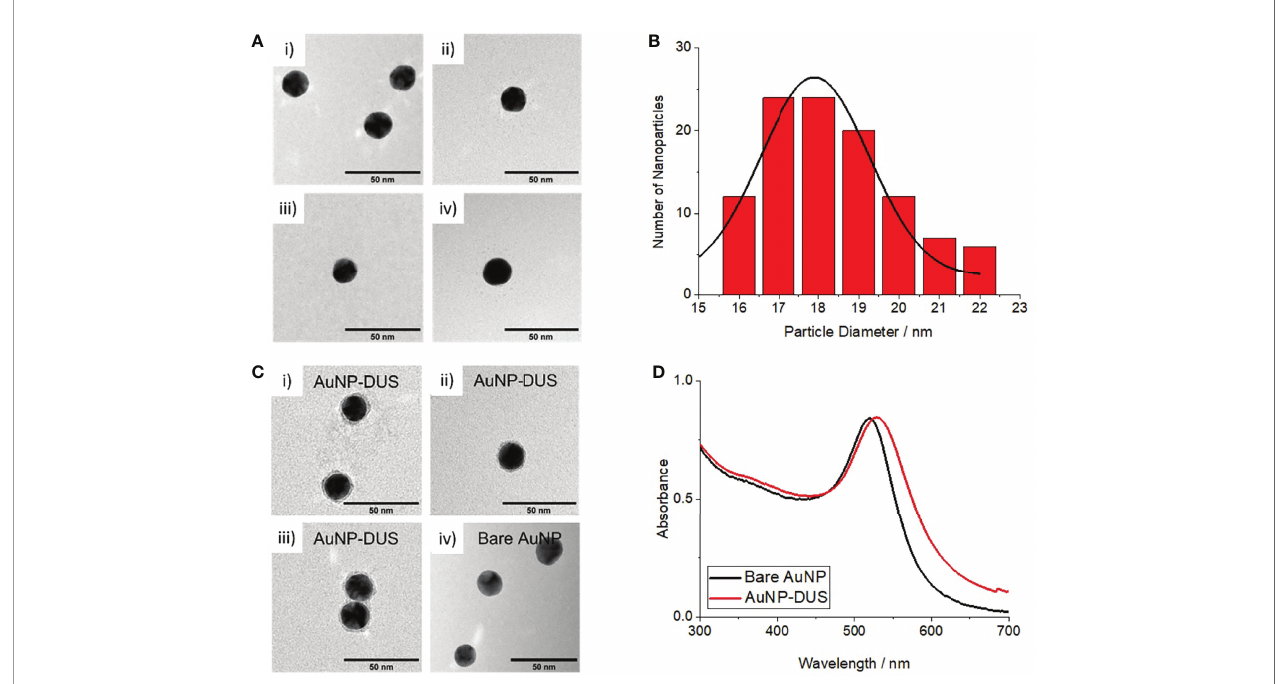
FIGURE 1 | Characterisation of bare AuNPs and DNA-functionalised AuNPs (nanoprobes) (A) TEM images of bare AuNPs, i-iv) individual images taken from random position on the TEM grid (B) Histogram of measured particle diameters for bare AuNPs (C) i-iii) TEM images of AuNP-DUS with uranyl acetate staining showing DNA conjugated to the particles surface, iv) TEM image of bare AuNP with same uranyl acetate staining showing no peripheral staining, (D) UV-visible absorbance spectrum of bare AuNPs (black) and nanoprobes (red) showing a 9nm shift in surface plasmon resonance (SPR) upon